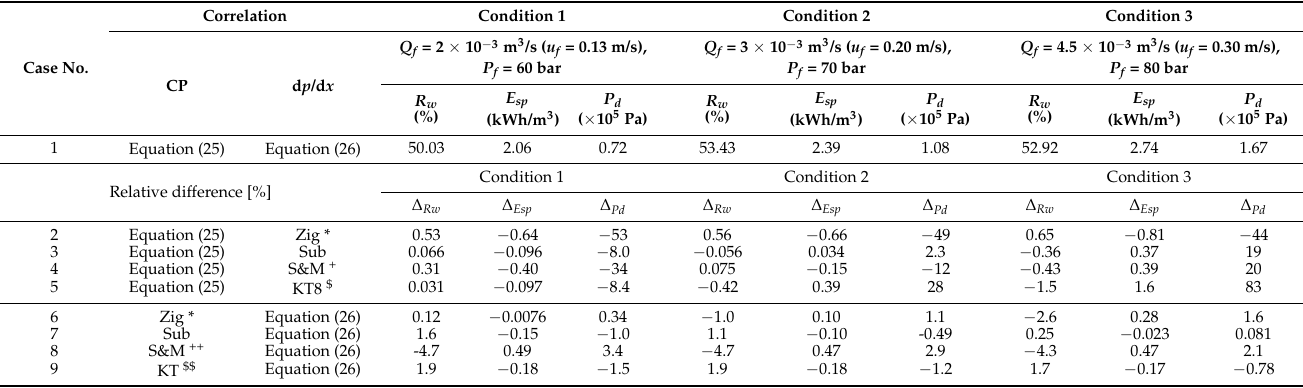
Table 6. Simulation results for water recovery R w , specific energy consumption E sp and feed pressure drop P d , with different combinations of CP and pressure drop correlations under three simulation conditions (with feed concentration c f = 35kg/m 3